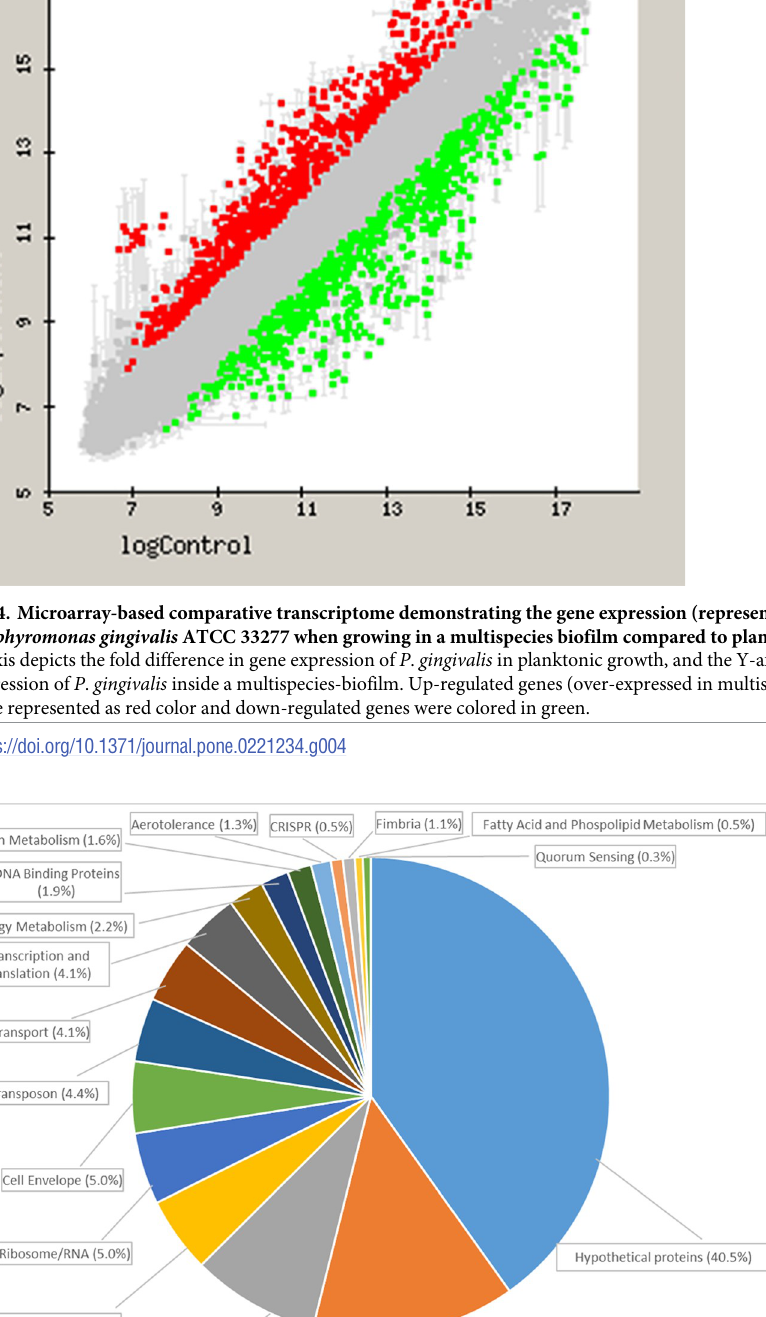
PLOS ONE | https://doi.org/10.1371/journal.pone.0221234 August 22,